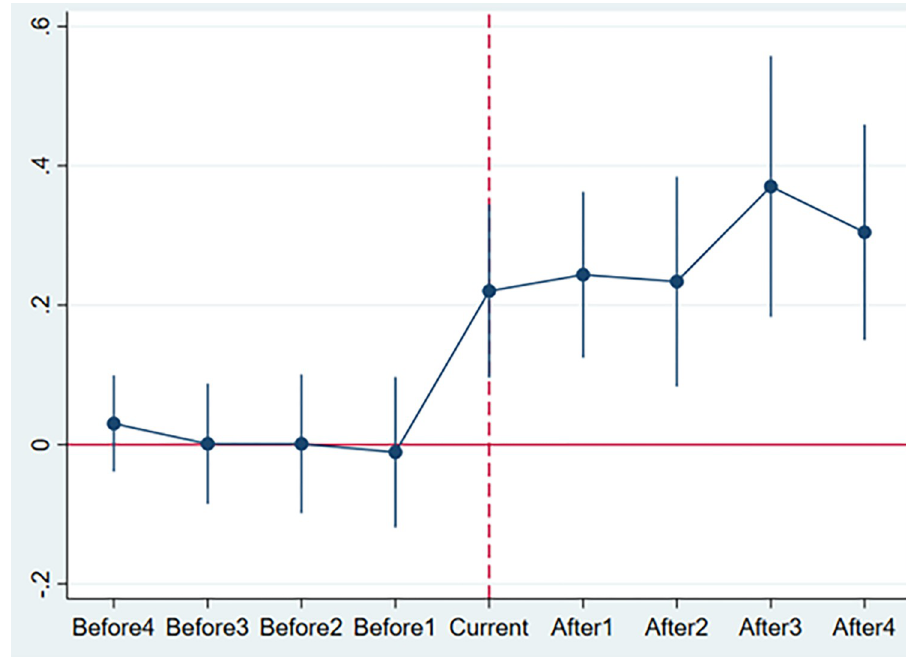
Fig 2. Parallel-trend